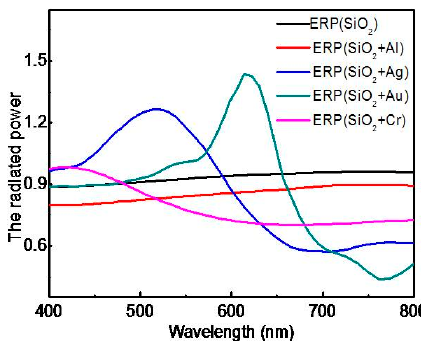
Figure 2. The radiated powers of without metal and with four kinds of metal nanoparticles (NPs). FromFigure2, theradiatedpowerofAgNPsis1.31, butitseffectiveradiatedpower(ERP)isonly0.93.